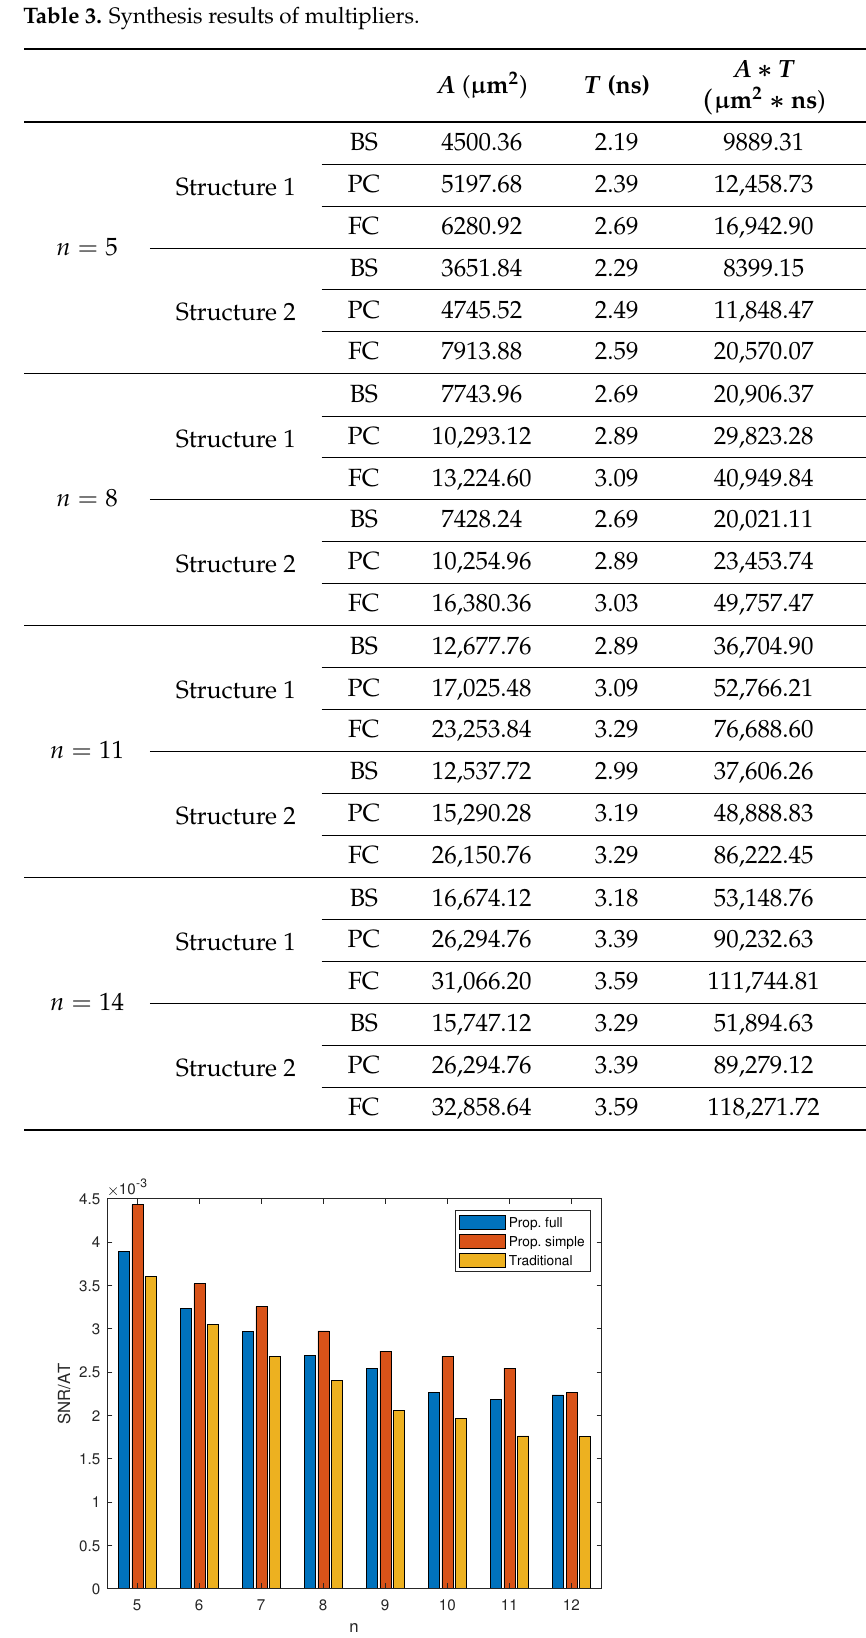
Figure 8. Hardware efficiency of two kinds of multipliers (higher is